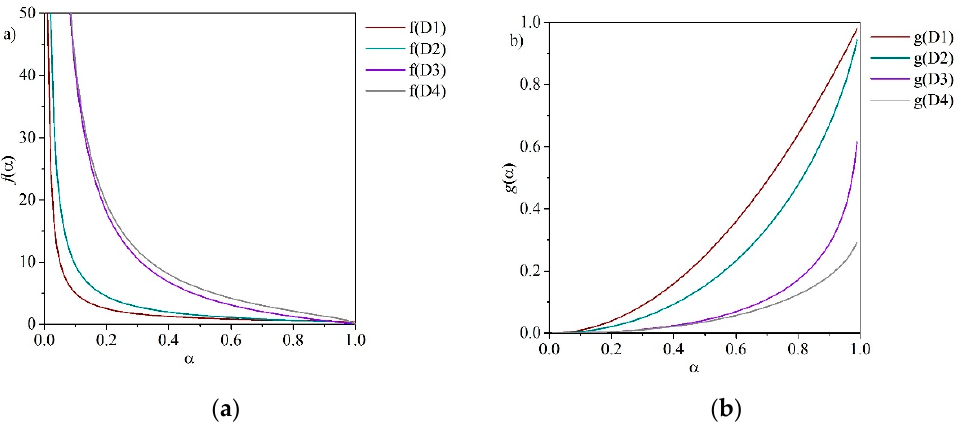
Figure 8. Diffusion-based reaction models: ( a ) f ( α )plots; ( b ) g ( α ) plots. Figure 8. Di ff usion-based reaction models: ( a ) f ( α )plots; ( b ) g ( α )